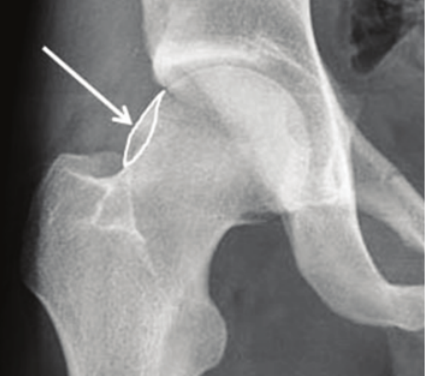
Figure 2: Illustration of a femoral bump seen on a radiograph (arrow, marked area). It is defined as an aspherical part of the femoral head-neck